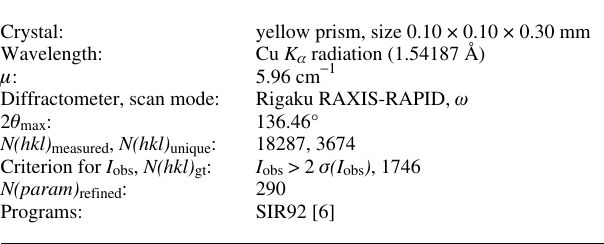
Table 1. Data collection and handling.